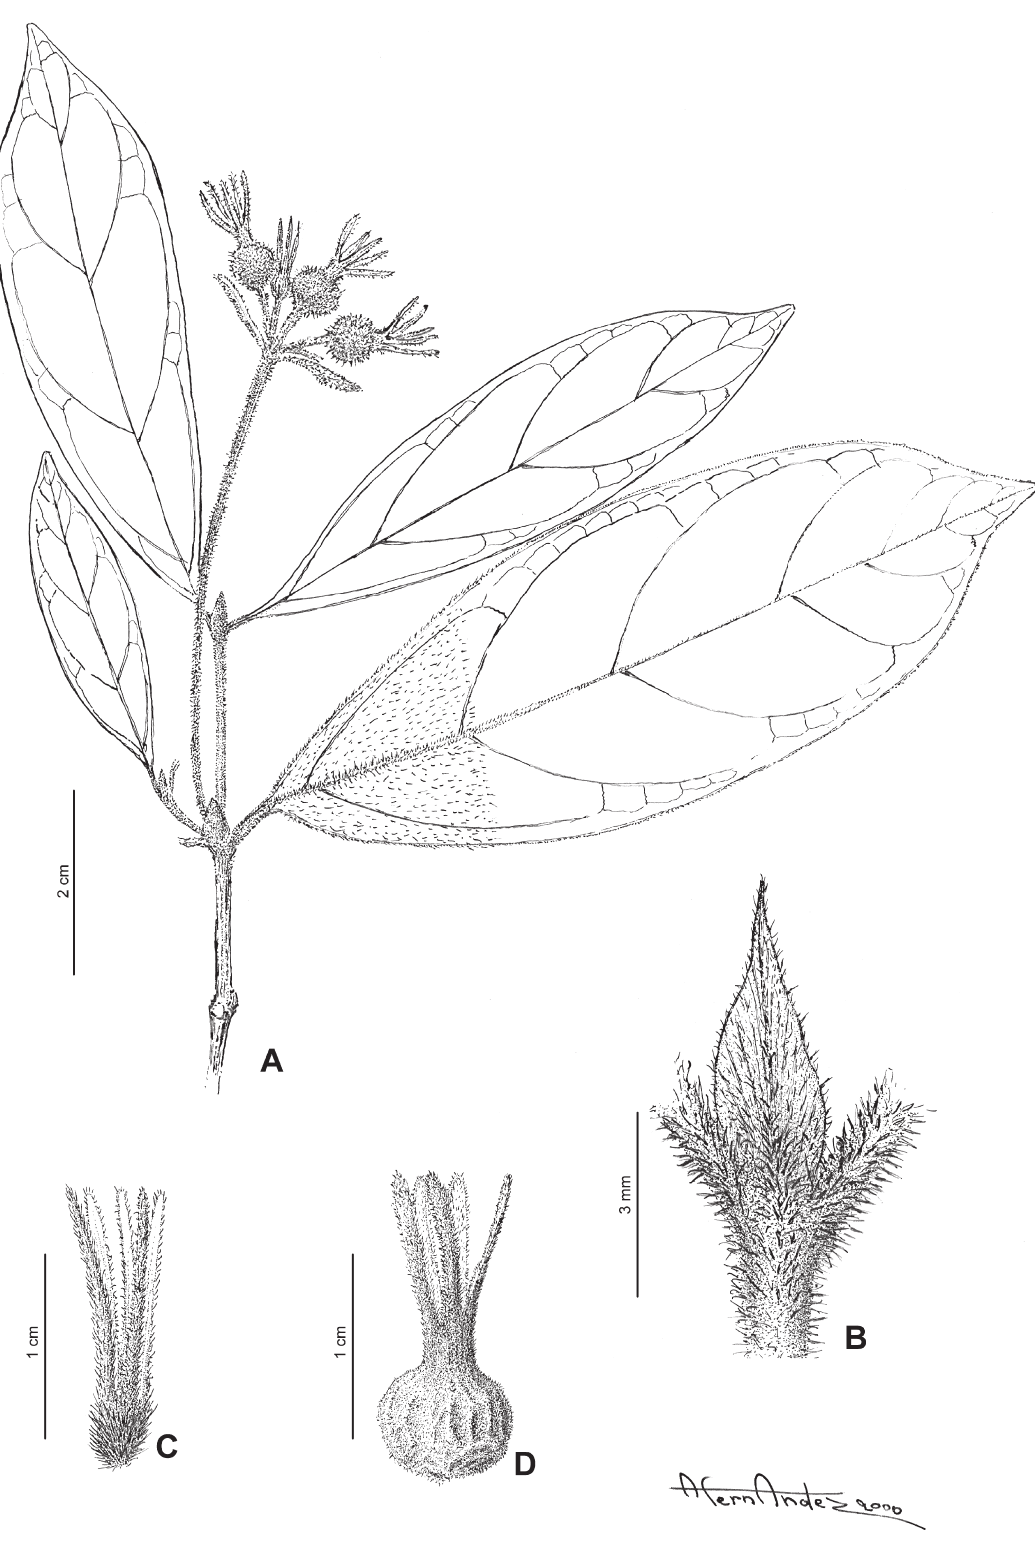
Fig. 4. Homollea perrieri Arènes. A . Fruiting branch. B . Stipules. C . Ovary and calyx. D . Fruit. Drawn by Mr. A. Fernandez. A, C–D from Afzelius 259 ( P ) ; B from Perrier de la Bâthie 3633 ( P )